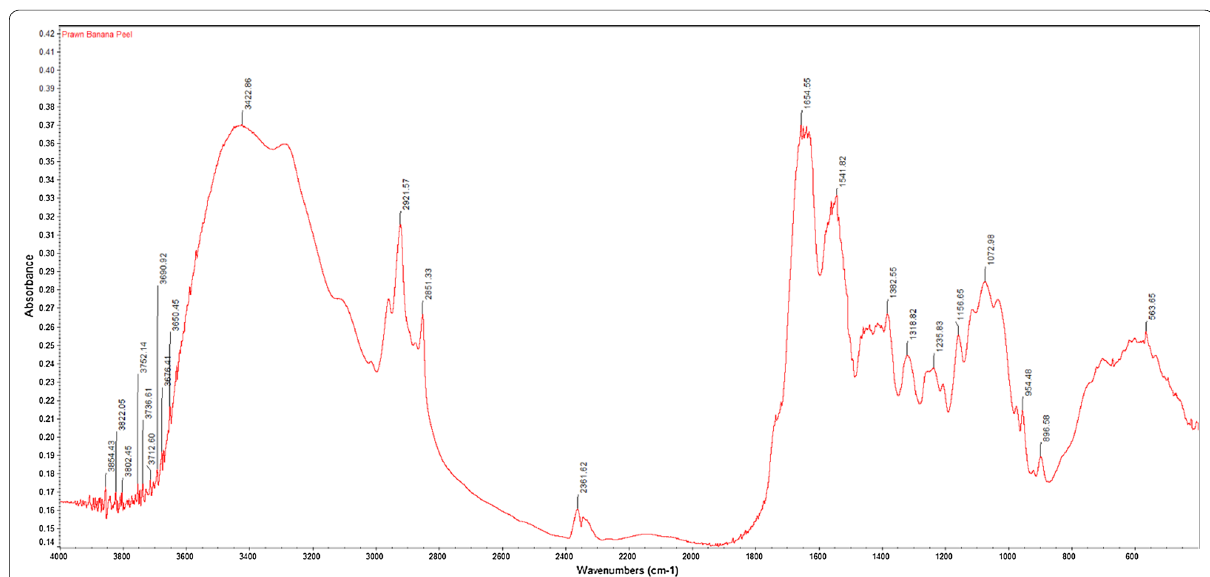
Fig. 3 FTIR spectra of extracted chitin from banana peel fermentation